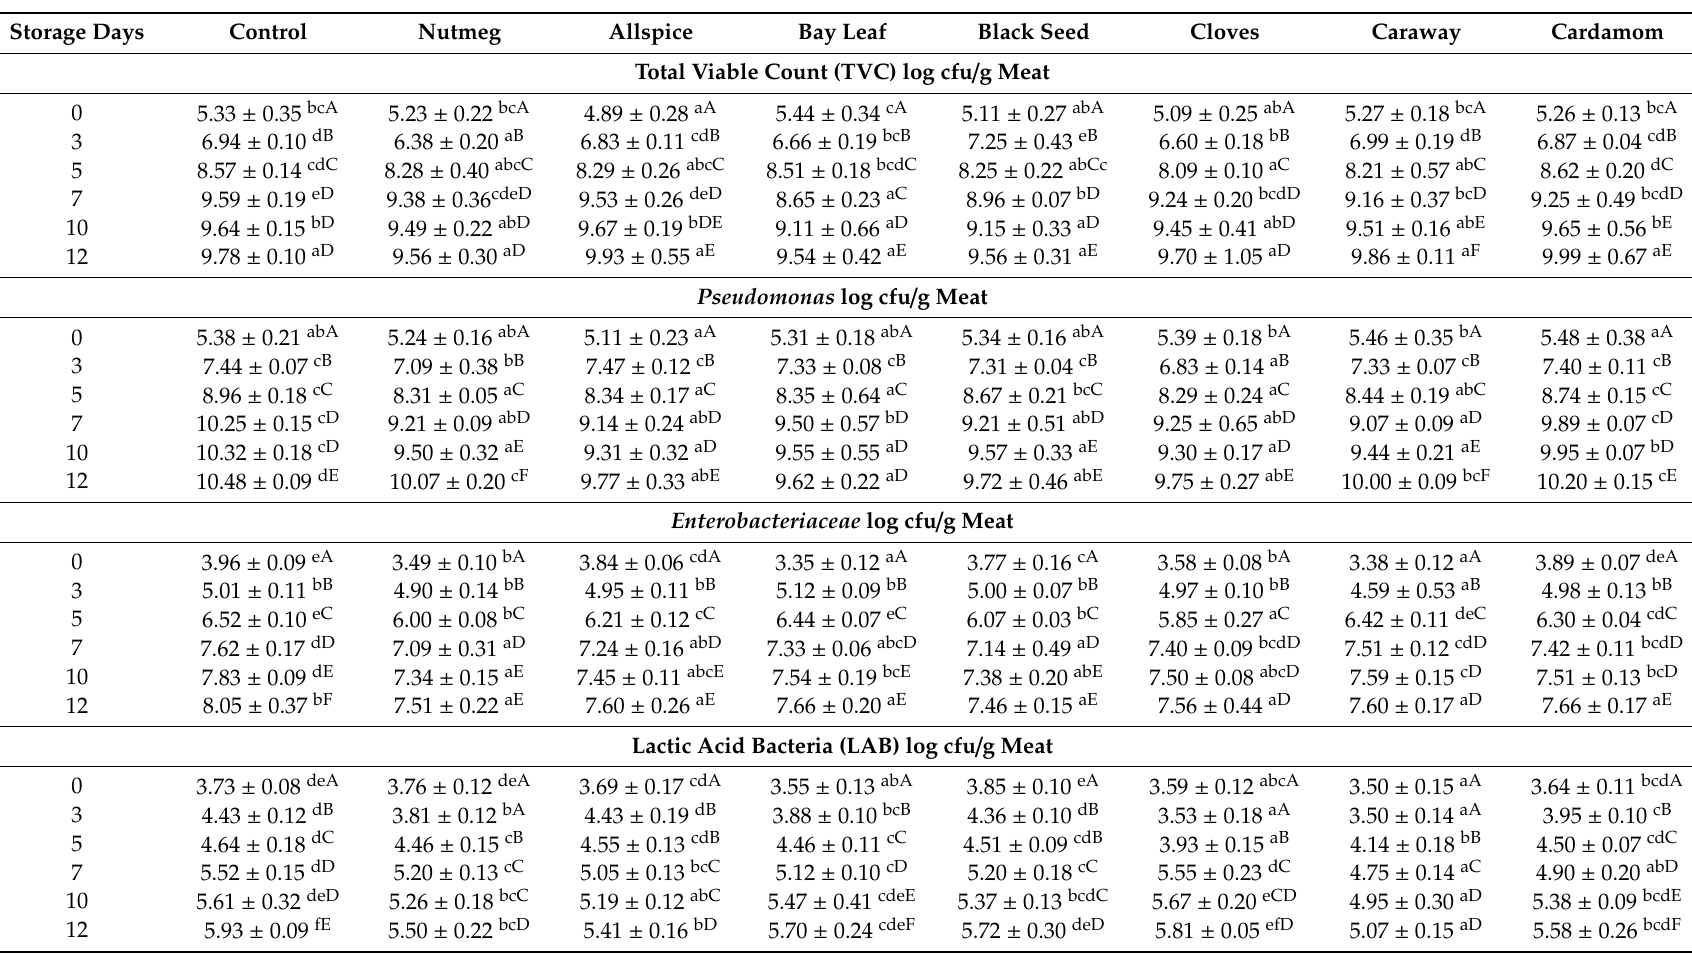
Table 5. E ff ect of various spice extract treatments on microbiological quality expressed as TVC—total viable count, Psedomonas , Enterobactericeae, and LAB—lactic acid bacteria of raw ground chicken legs during 12 days of refrigerated storage (4 ◦